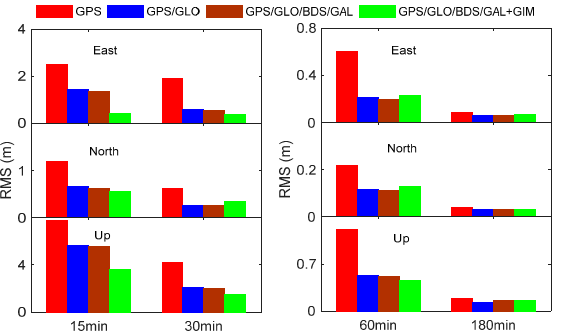
Figure 7. RMS statistics of positioning errors for different single-frequency PPP processing scenarios at the end of 15 min, 30 min, 60 min, and 180 min.